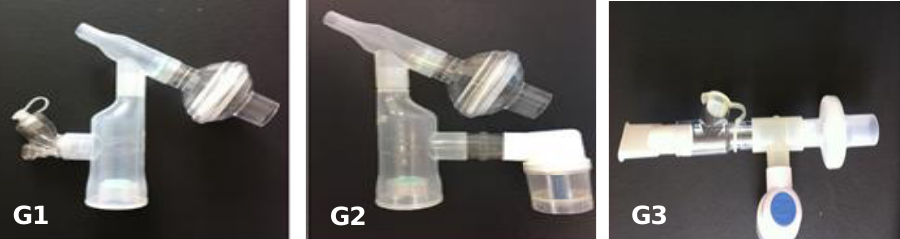
Figure 1. Nebulizer configurations used in this study. G1: mesh nebulizer with VHC, G2: jet nebulizer with VHC, and G3: jet nebulizer alone.